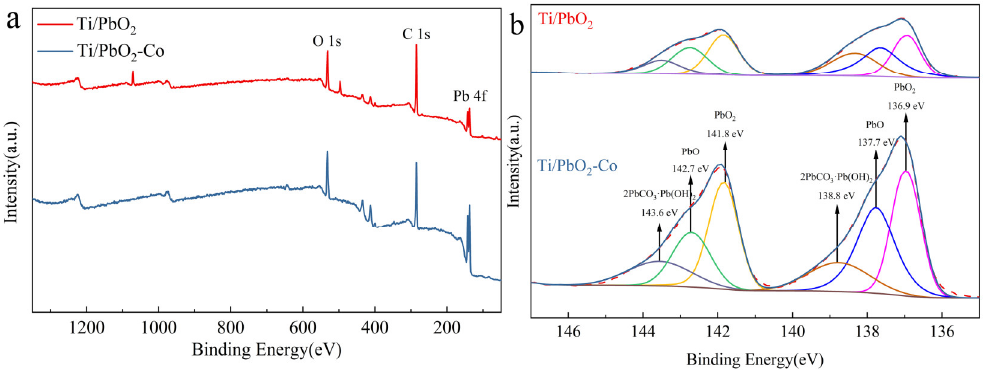
Figure 4. XPS image (( a ): full spectrum; ( b ): Pb) of the Ti/PbO 2 electrode.